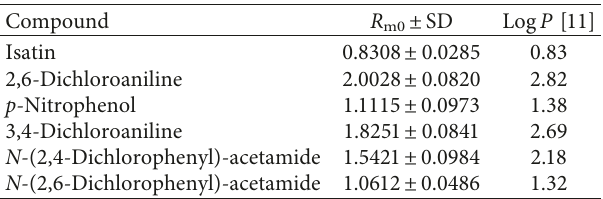
m0 and Log P values of the compounds with a known